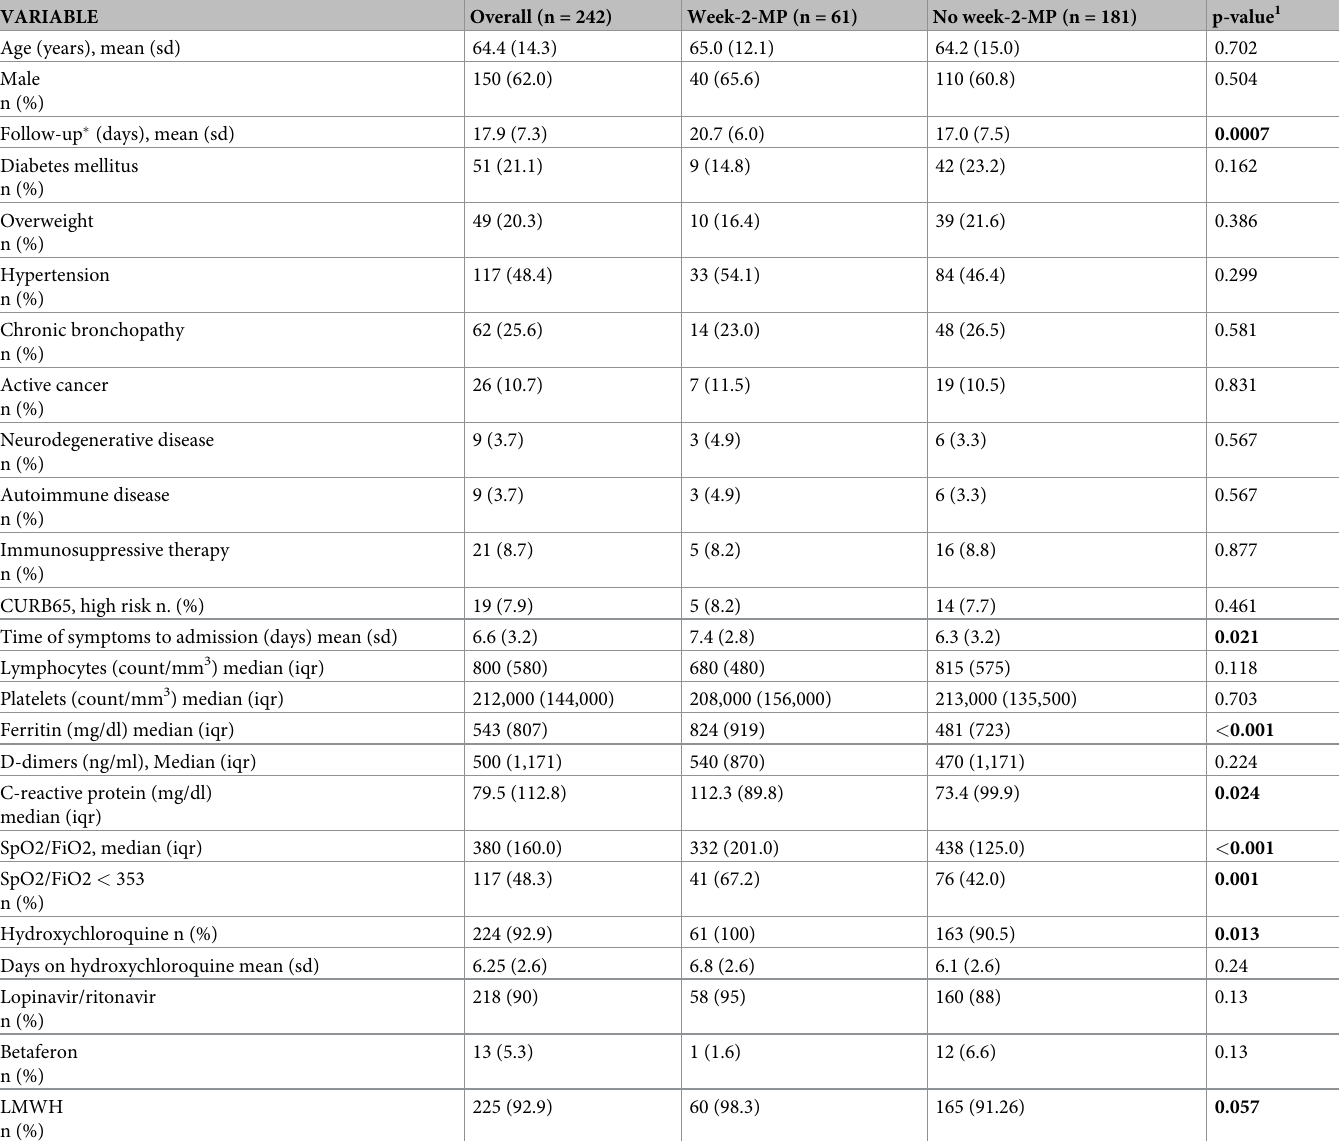
Table 1. Clinical characteristics of the cohort according to treatment with